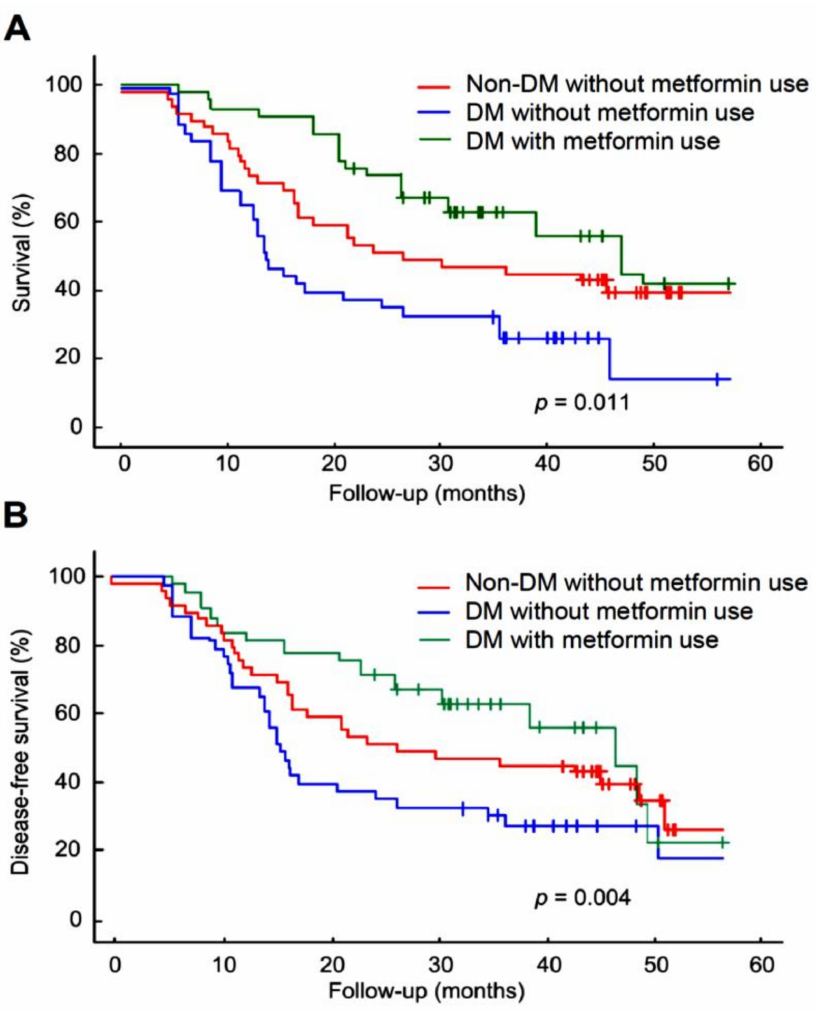
Figure 1. Kaplan–Meier analysis of ( A ) overall survival and ( B ) disease-free survival for patients with or without metformin treatment. A chi-squared test was performed to analyze the continuous variable between the groups. A p -value of less than 0.05 was considered statistically